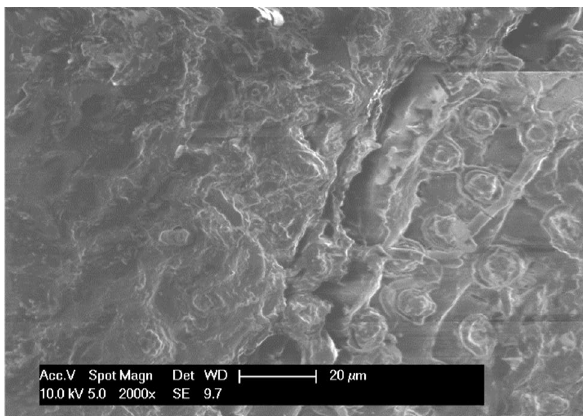
Fig. 1 SEM micrograph of MSC before adsorption of CR dye